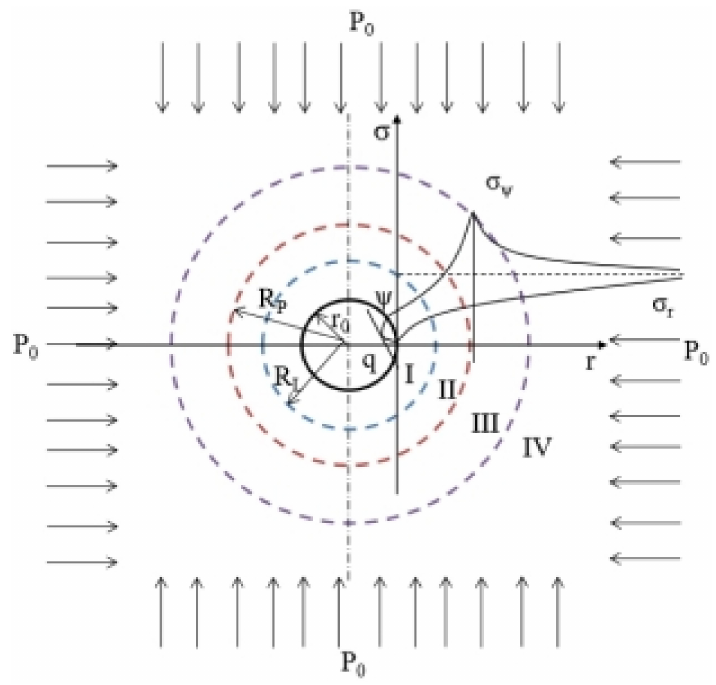
Figure 2. Stress distribution around the